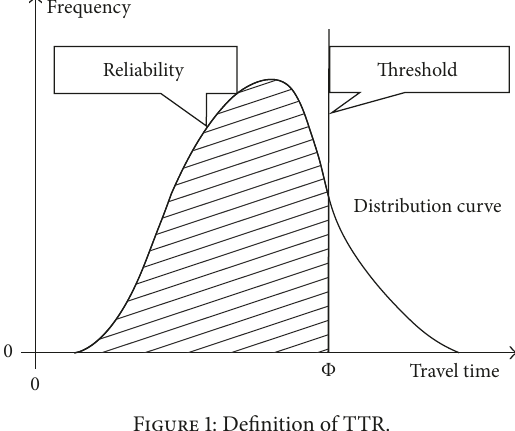
Figure 1: Definition of